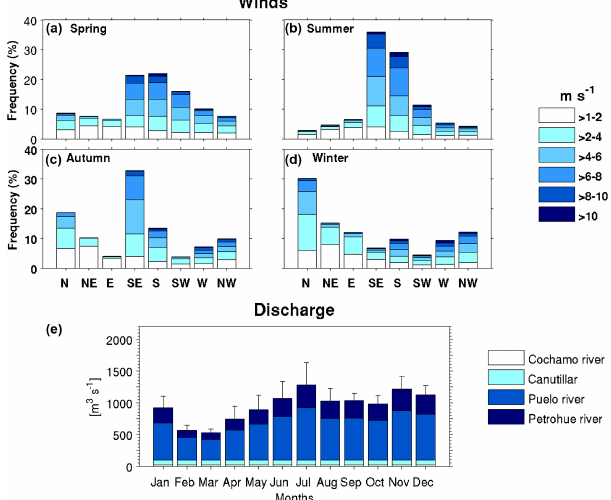
Figure 2. Seasonal variability of the wind vector in the Reloncaví fjord during the period June 2008 to March 2011. Frequency his- tograms of direction and magnitude for each season: (a) spring, (b) summer, (c) autumn and (d) winter. The annual cycle of the dis- charge into the Reloncaví fjord is shown in panel (e) . Notice that the Cochamó discharge is included but is low (20m 3 s − 1 ) compared to the other